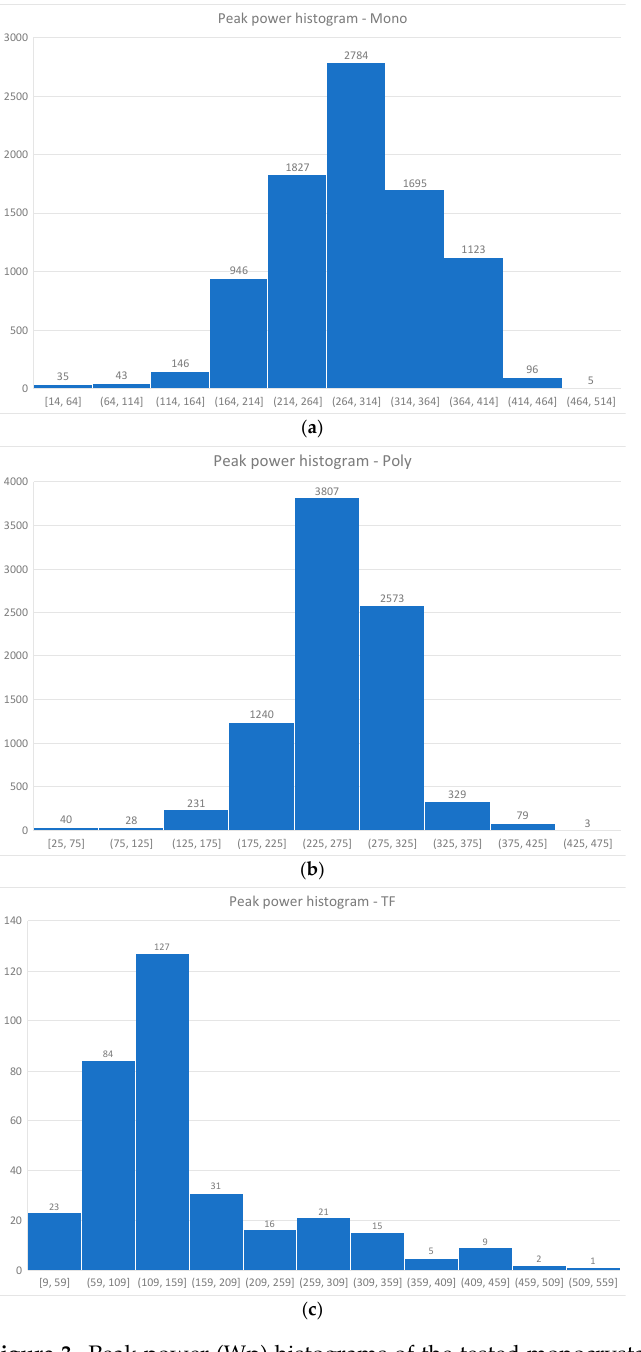
Figure 3. Peak power (Wp) histograms of the tested monocrystalline (Mono) ( a ), polycrystalline (Poly) ( b ), and thin film (TF) PV modules ( c ). The modules’ power output provided by the one diode and three parameters (PDC1) model and by the simplified one diode and three parameters (PDC2) were compared